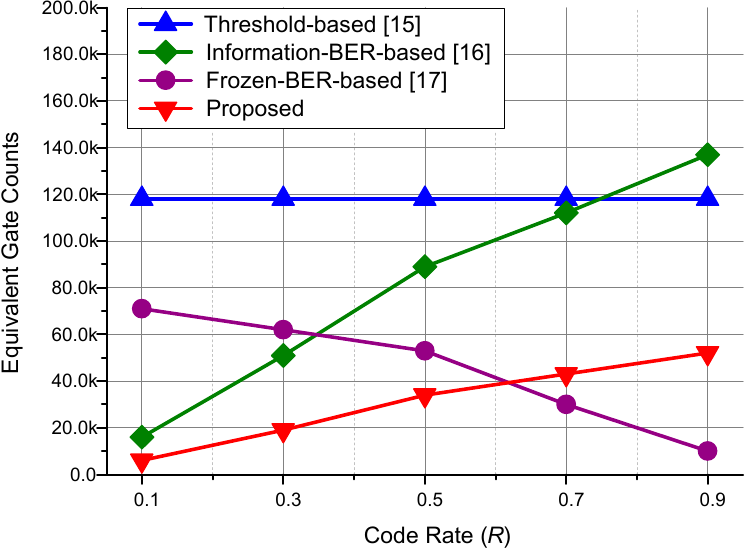
Figure 8. Equivalent gate counts of threshold-based [15], information-BER-based [16], frozen-BER- based [17], and proposed early-termination algorithms according to code rate.